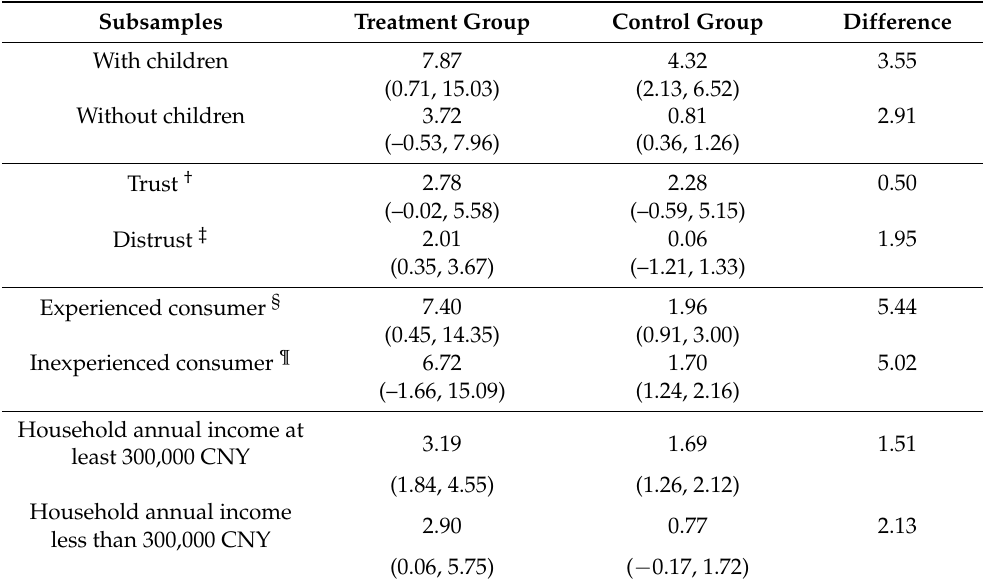
Table 6. Heterogeneity of consumers’ WTP (CNY per